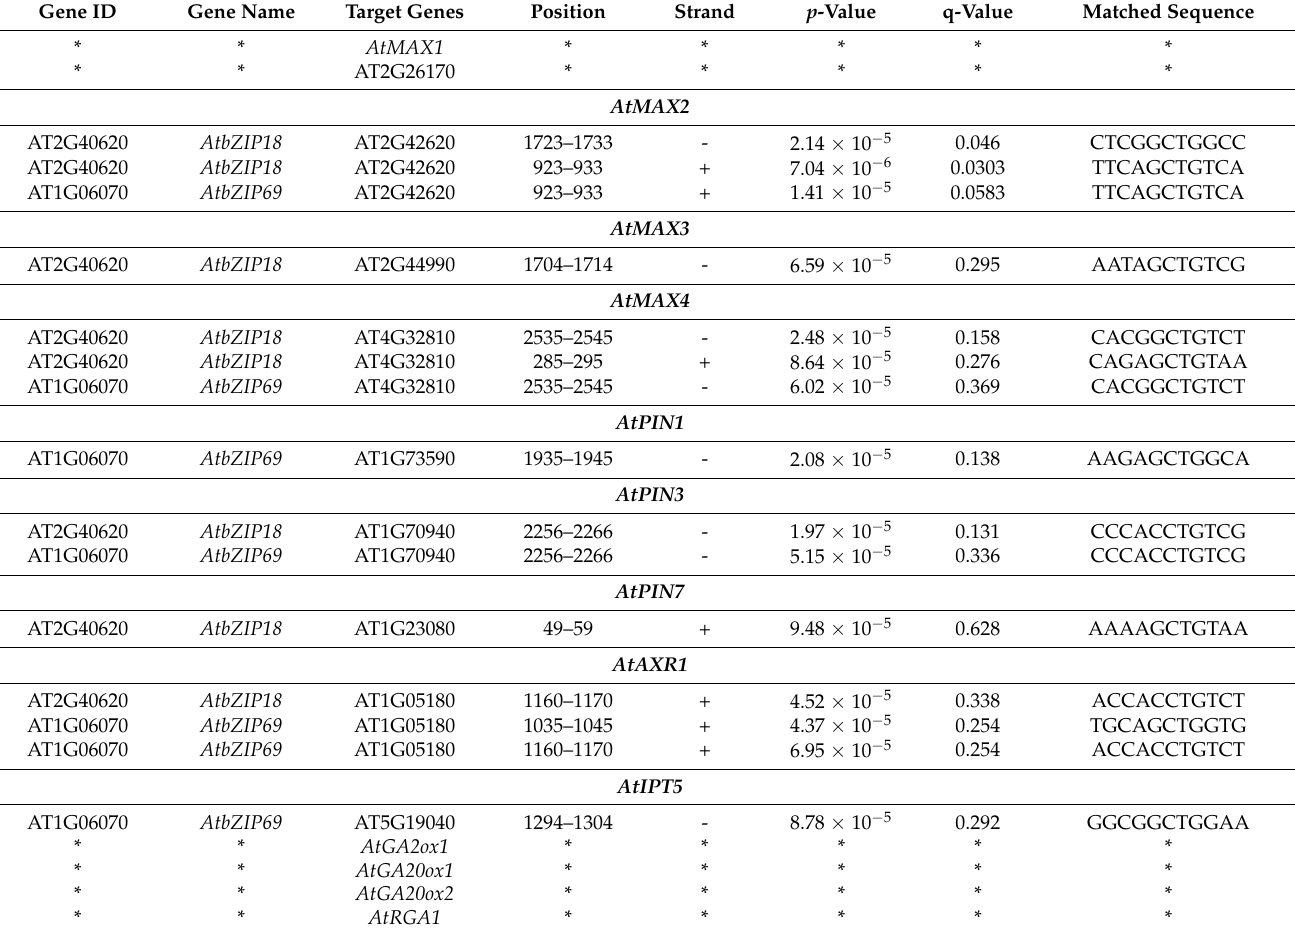
Table 1. Transcription factor binding sites